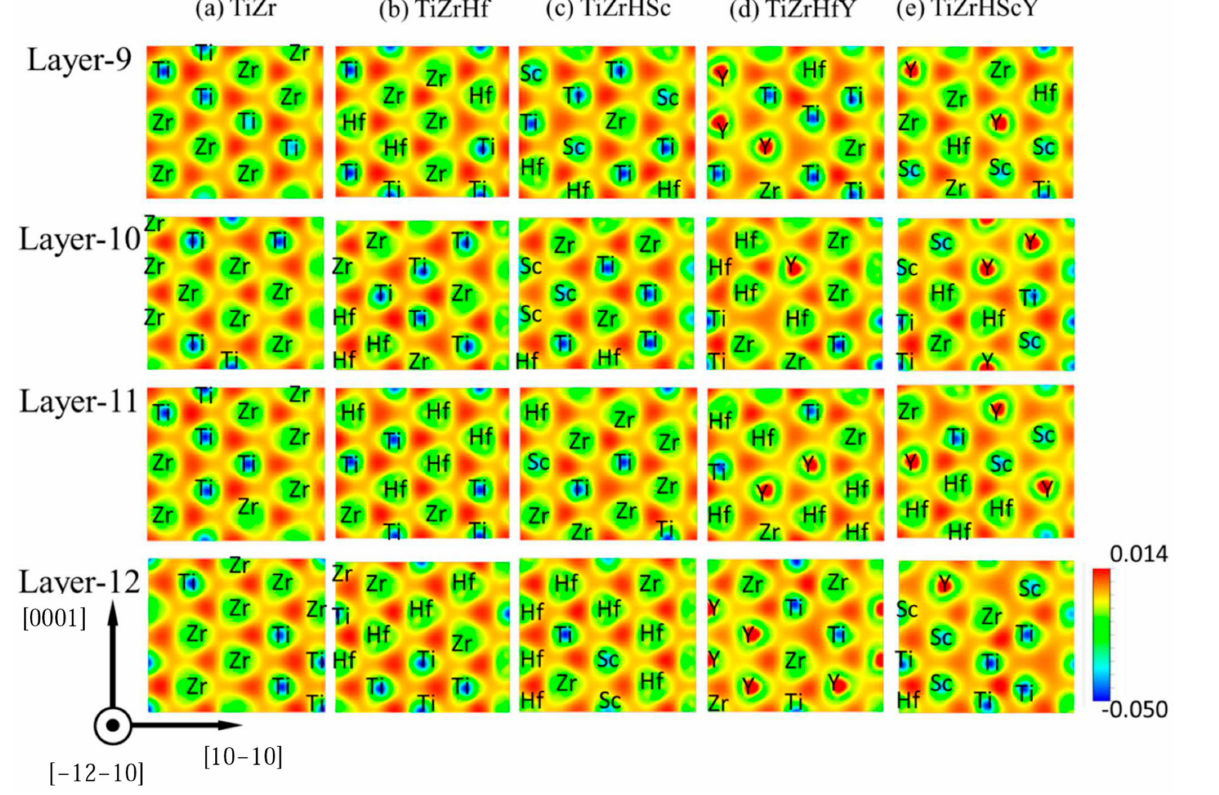
Figure 5. The redistribution of charge density ( ∆ ρ ( r )) at some atom layers in the supercells of TiZr-based CSAs, ( a ) Ti 120 Zr 120 , ( b ) Ti 80 Zr 80 Hf 80 , ( c ) Ti 60 Zr 60 Hf 60 Sc 60 , ( d ) Ti 60 Zr 60 Hf 60 Y 60 and ( e ) Ti 48 Zr 48 Hf 48 Sc 48 Y 48 . The color bar indicates the values of ∆ ρ ( r ), in units of eV/bohr 3 . The atom layers 9–12 are close to the (0001) glide plane and are related to the formation of twins or faults shown in Figure